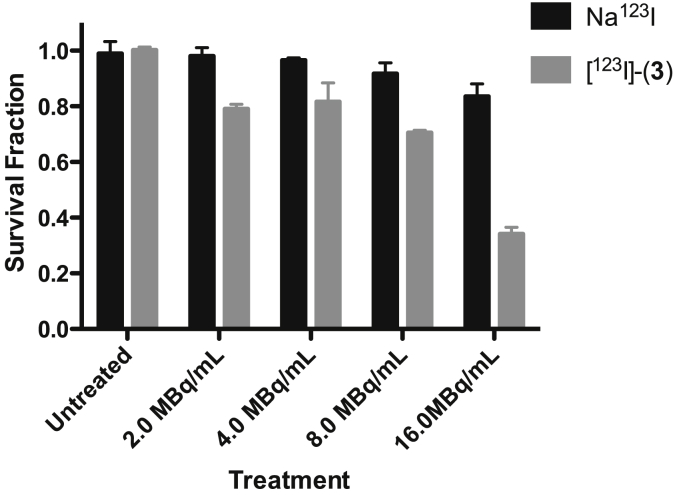
Clonogenic survival data for MDA-MB-435 cell line after 24 h treatment with increasing activity concentrations of [123I]-(3) or Na123I.